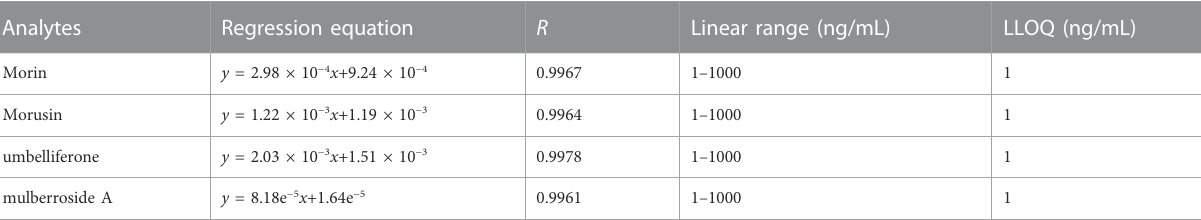
TABLE 2 analytical parameters for quanti fi cation of analytes. Analytes